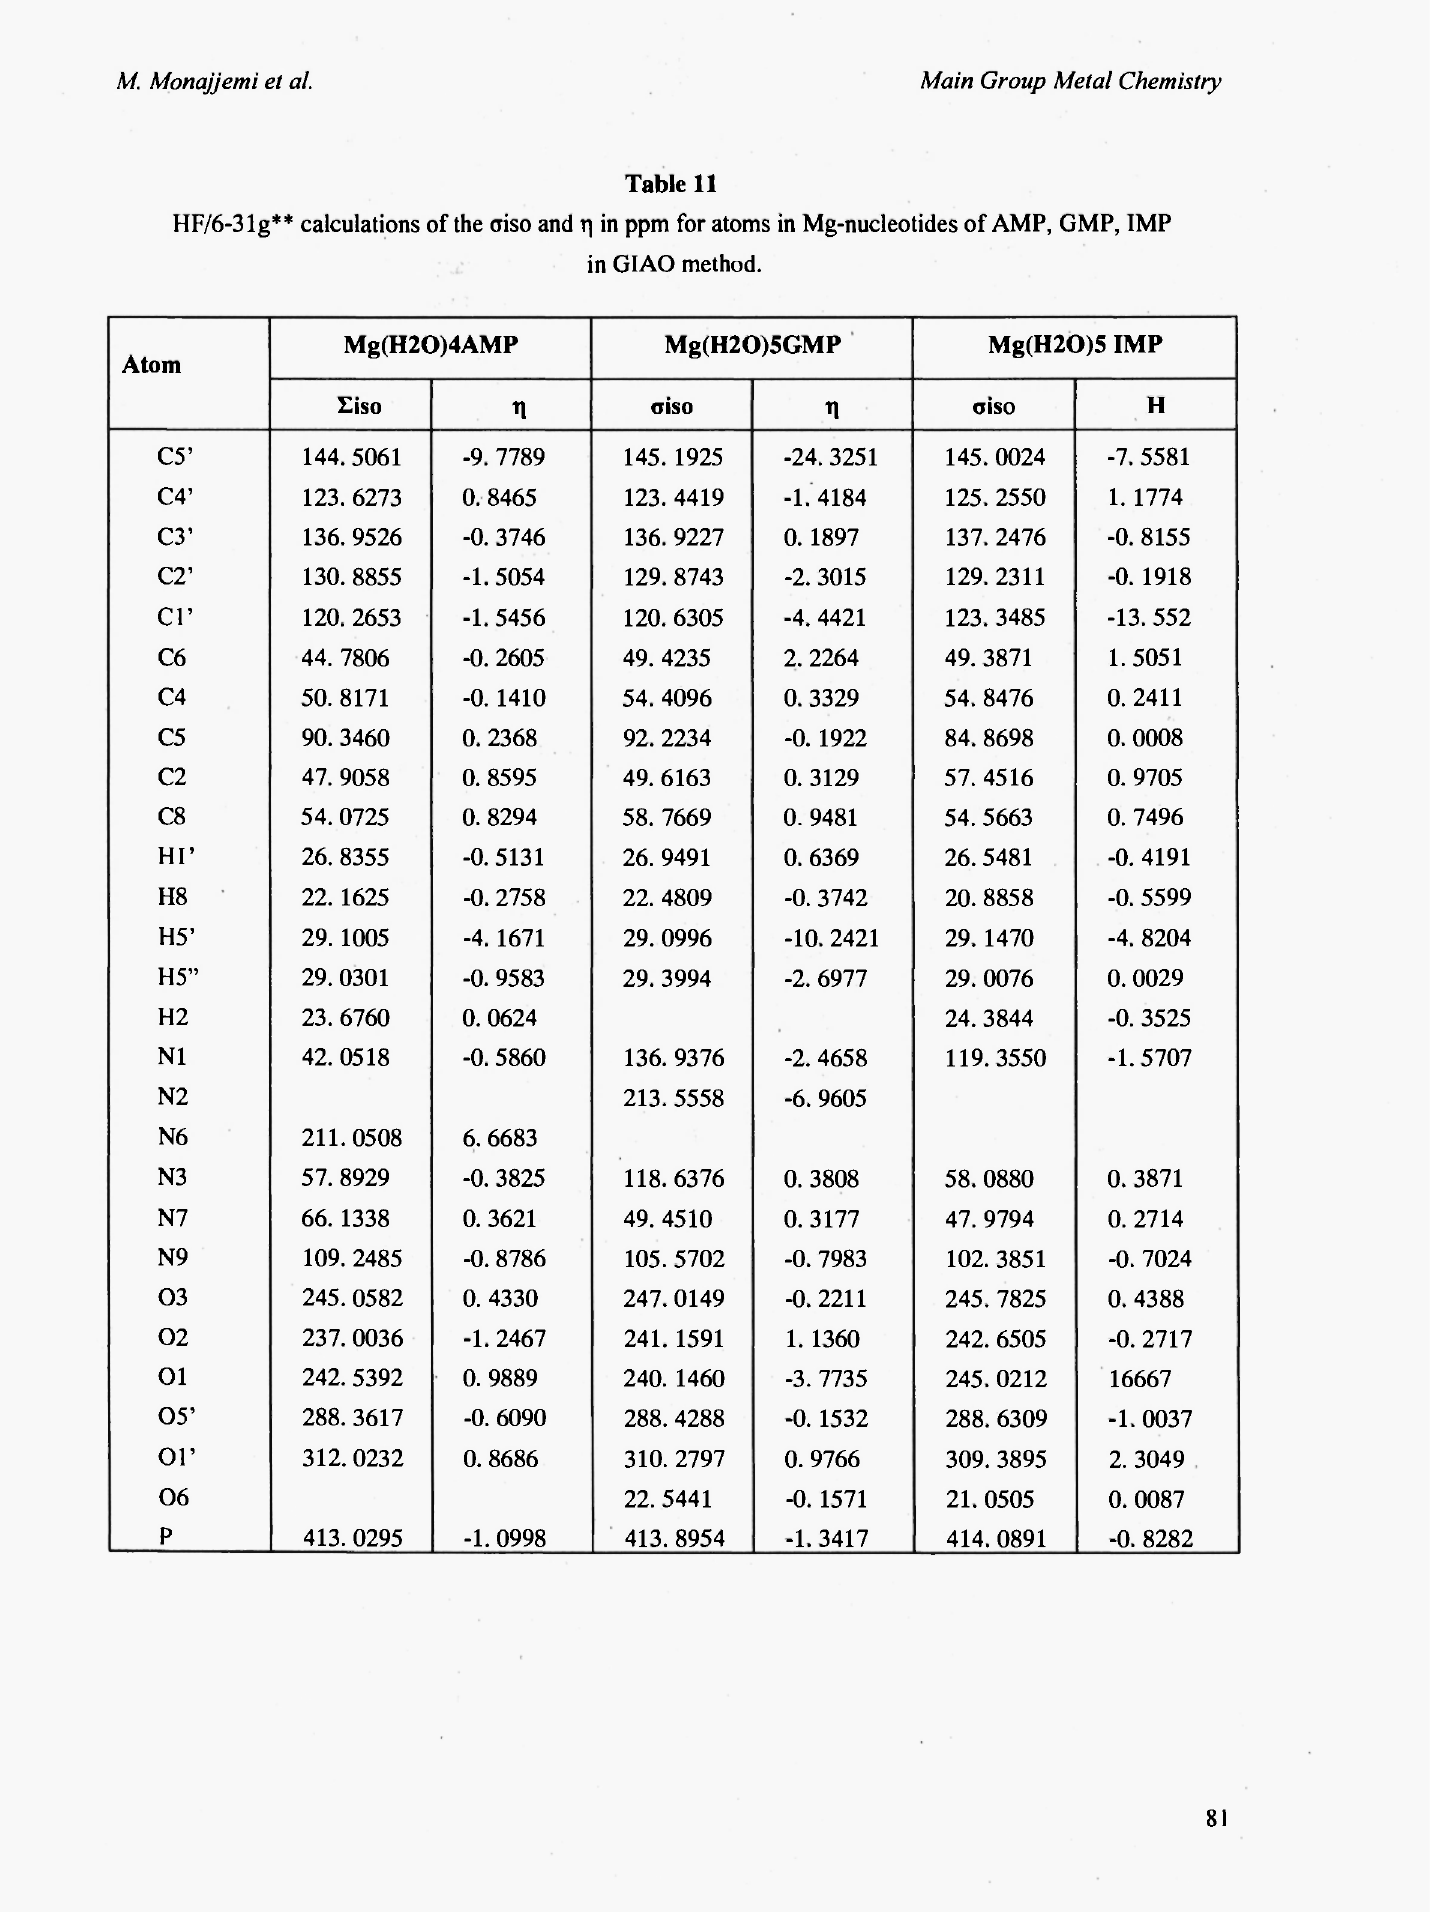
HF/6-3 lg** calculations of the oiso and η in ppm for atoms in Mg-nucleotides of AMP, GMP, IMP in GIAO